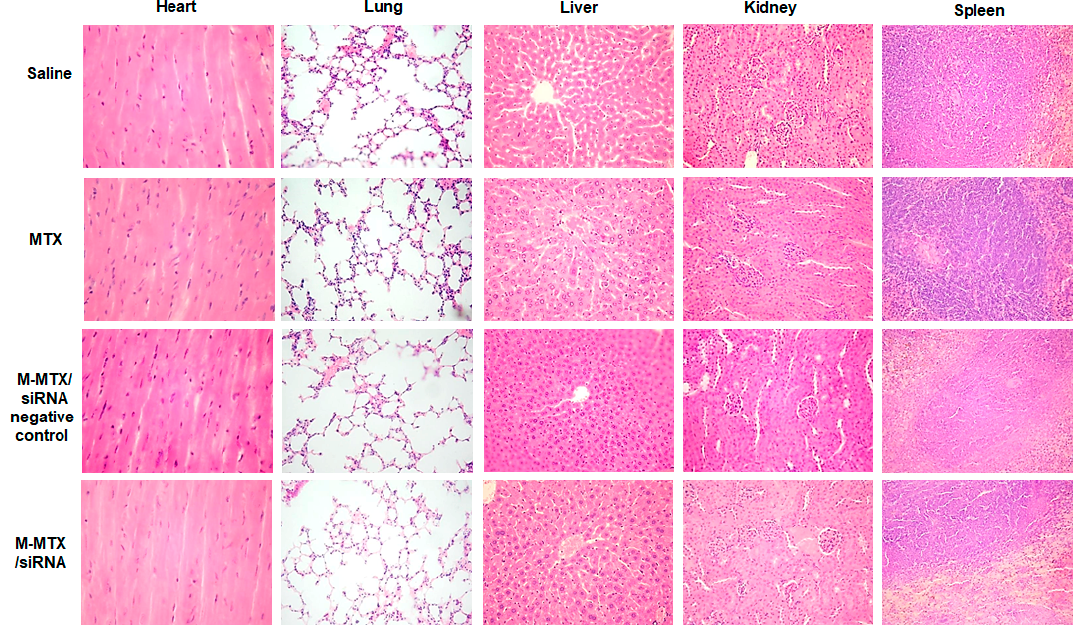
Figure 8. The organ toxicity analysis of different formulations: Major organs (Heart, Lung, Liver, Kidney, and Spleen) were dissected and stained with hematoxylin-eosin to assess the systemic toxicity of the drug formulations.